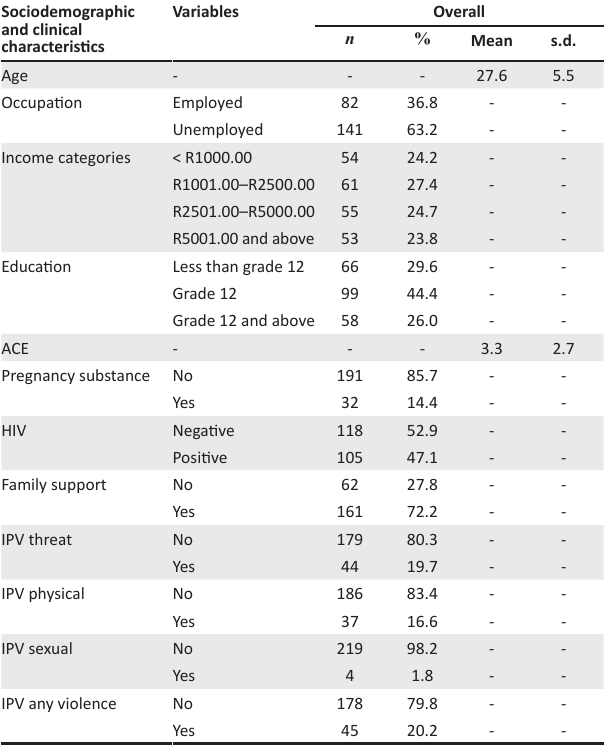
TABLE 1: Sociodemographic and clinical characteristics of study participants ( N = 223). Sociodemographic and clinical